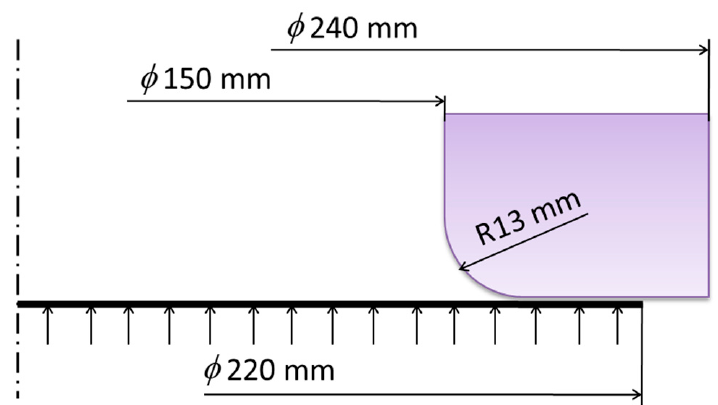
Figure 2. d A versus